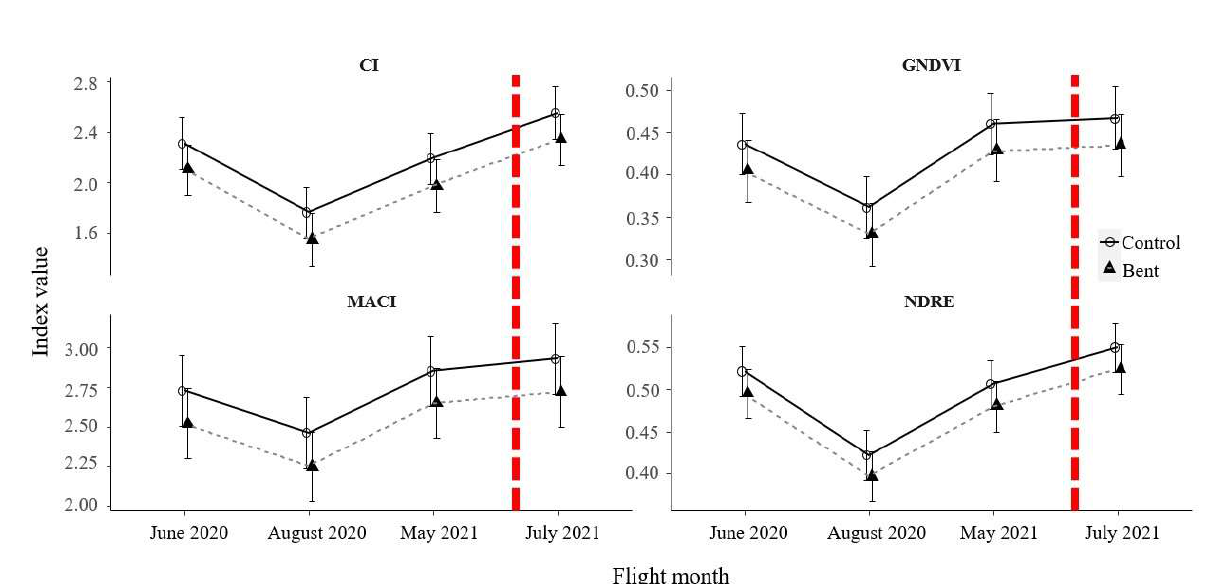
Figure 3 . Values of indices with p<0.05 ( lmer ), compared between groups and flights (±95% confidence interval). (The dashed red line shows the pre-longed drought at the beginning of summer in